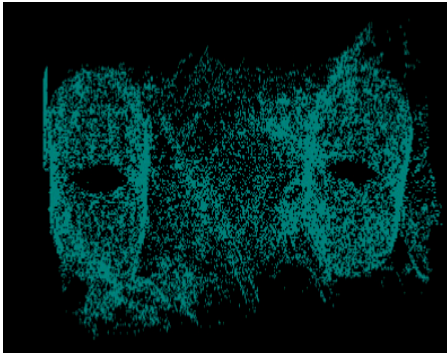
Figure 12. Three-dimensional spatial structure of the axially braided C/C composites interface by Micro-CT.